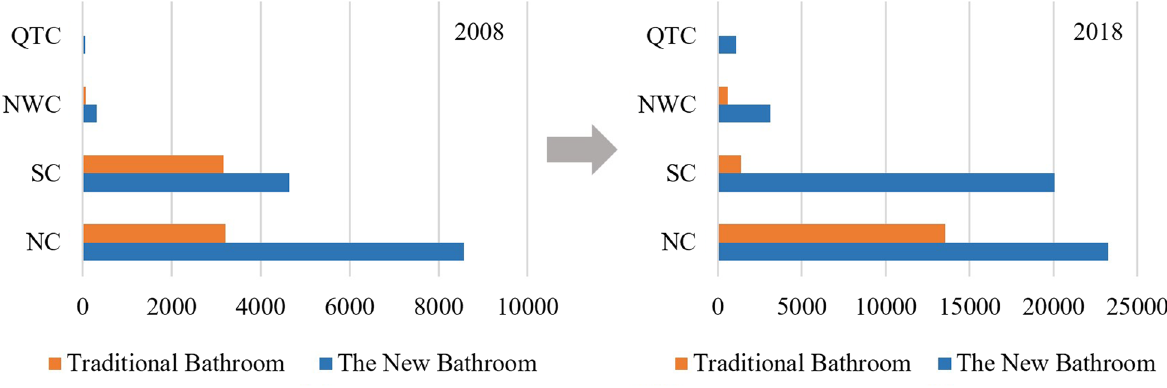
Fig. 1 Bath industry and its sub-category growth comparison chart